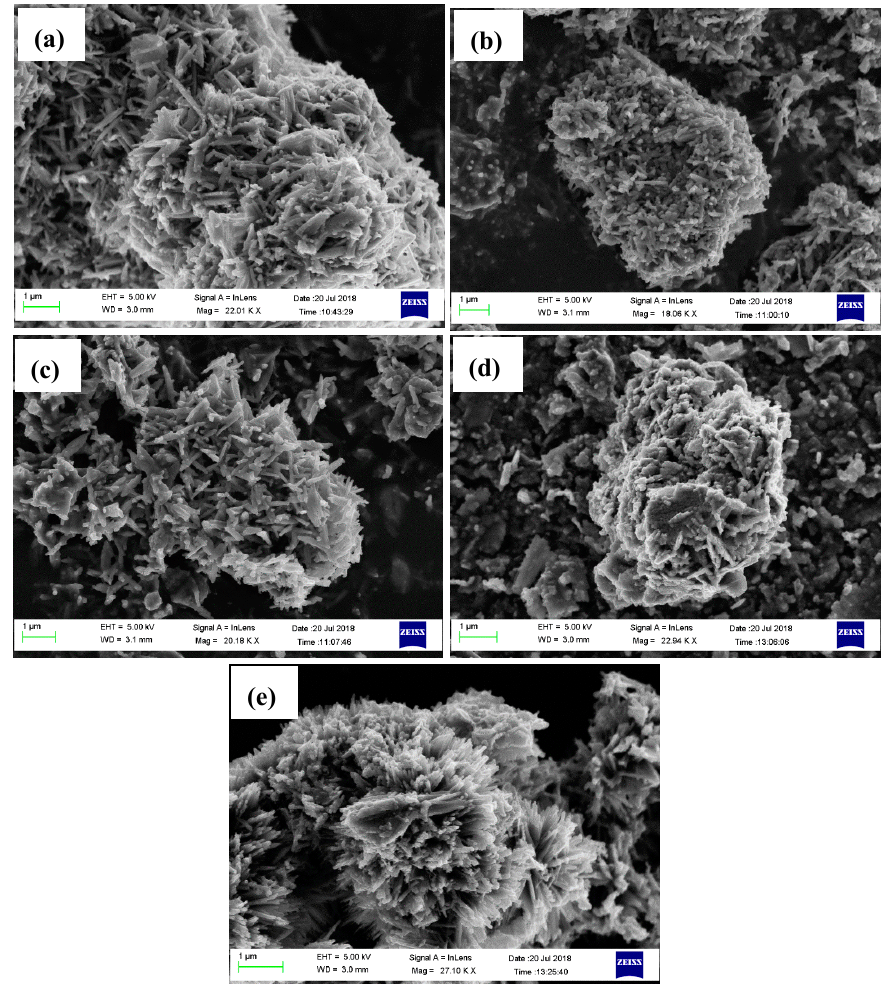
Figure 3. SEM images for ( a ) NiCo 2 O 4 /Co–CX, ( b ) NiCo 2 O 4 /Ni–CX, ( c ) NiCo 2 O 4 /Fe–CX, ( d ) ZnCo 2 O 4 /Co–CX, and ( e ) Zn–Ni–Co/Co–CX.